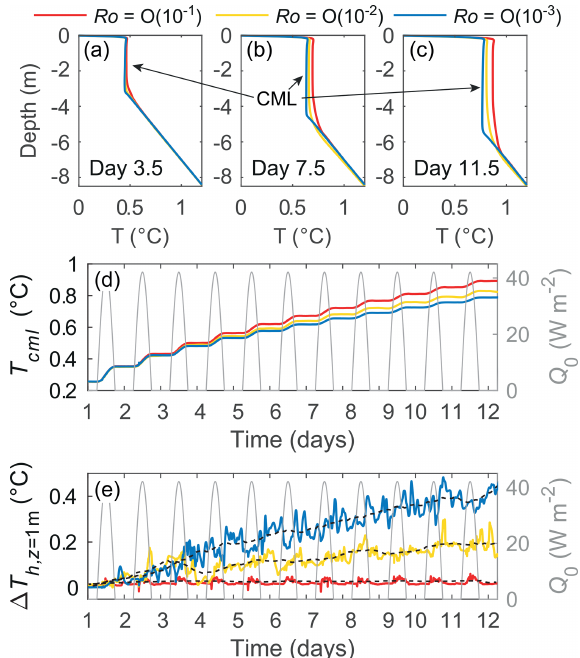
Figure 2. Warming of the CML in the lake interior and differential heating. (a–c) Laterally averaged midday temperature profiles on given days in the lake interior (lake volume below the surface area of the control volume in Fig. 1d). (d–e) Time evolution of (d) tem- perature in the interior of the CML (average in the control volume in Fig. 1d) and (e) the horizontal temperature gradient at 1m depth between the littoral region and the lake interior (profiles P1 and P2 in Fig. 1d). Black dotted lines in (e) show the 24h moving averages.